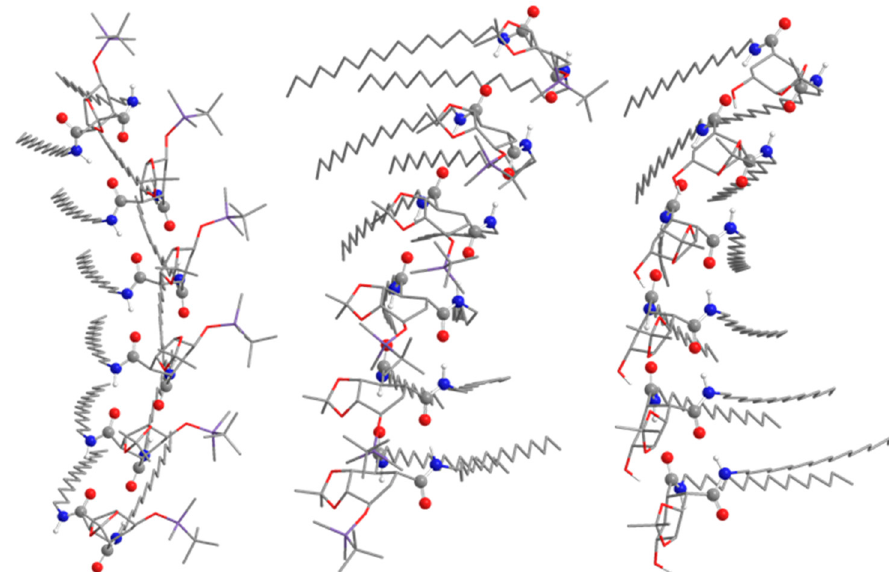
Figure 5. Front views of central 6 molecules in octameric 1-D aggregates (amide hydrogen-bonds) of cis - and trans - 2 , and 3 . Non-polar hydrogen atoms have been omitted for clarity. Atoms in amide groups have been represented with red (oxygen), blue (nitrogen) and grey (carbon) spheres.